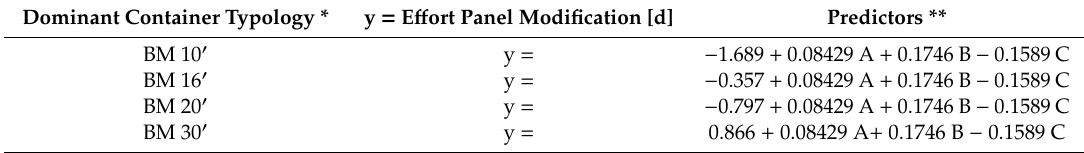
Figure 17. Pareto chart of the standardized effects for the determination of the total panel modification effort, α = 0.1. Factor abbreviations: ( A ) Number containers, ( B ) Overall number panels to be modified, ( C ) Number of entire walls to be modified, and ( D ) Container typology. Table 5. Regression